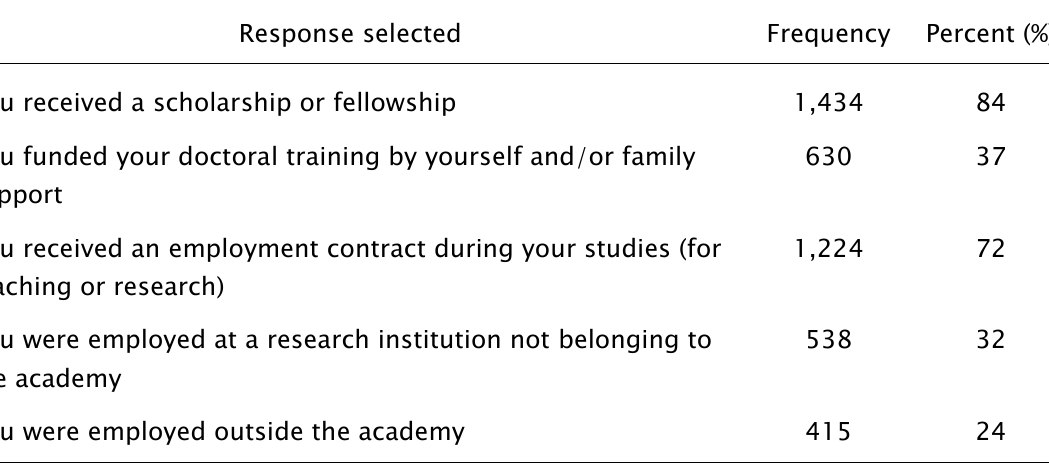
Respondents Who Selected the Following Responses to Question A6 Response